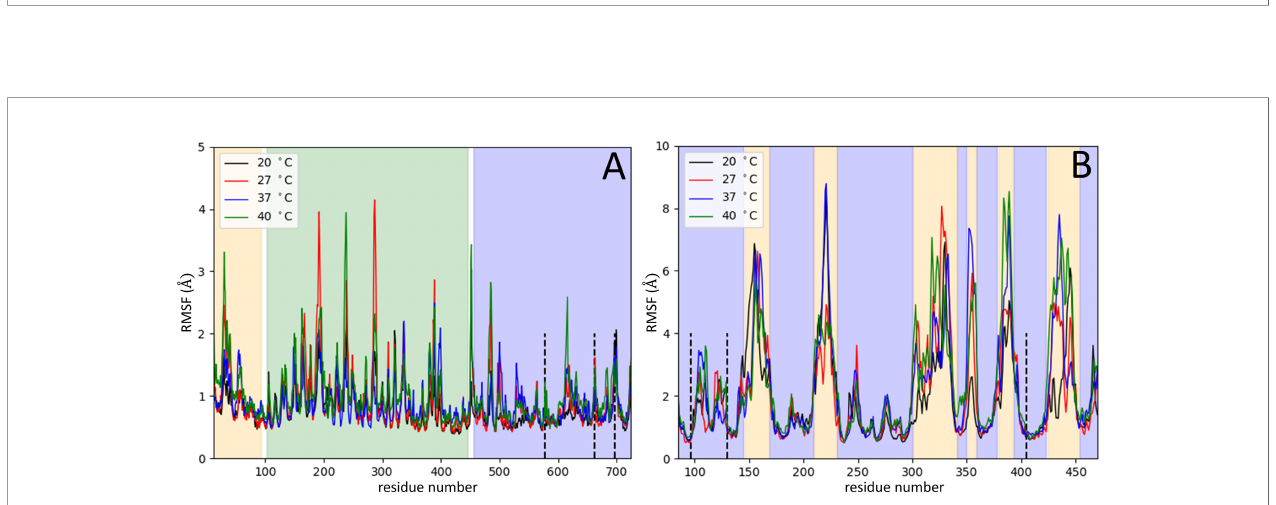
FIGURE 7 | Serine proteases variation in Root Mean Square Fluctuation. The RMSF measures (Å) were obtained per residue at different temperatures: 20°C (black), 27°C (red), 37°C (blue) and 40°C (green). RMSF variation for residues of OPB (A) and for residues of S13 (B) . In panel (A) , the OPB catalytic domain N-terminal region (pale orange), the C-terminal region (blue), the b -propeller domain (green), the hinge regions (white), and the catalytic triad (Ser577, His697, and Asp662) in dotted lines. Panel (B) represents the catalytic domains of S13 (blue region), in which the 6 six regions with the highest fl exibility (pale orange), and the catalytic triad (Ser-577, His-697, Asp-662) in dotted lines.